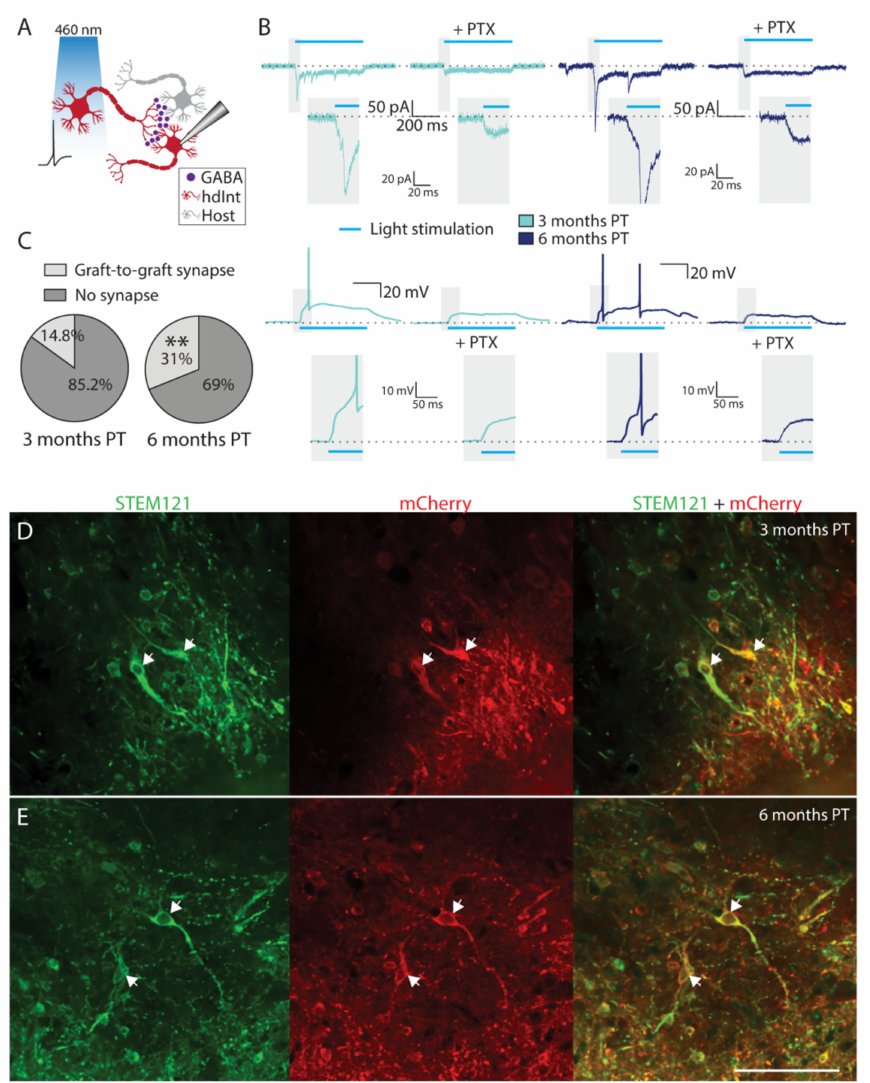
Figure 4. Graft-to-graft synaptic connectivity. ( A ) Cartoon representing a recording from a grafted hdInt receiving inhibitory synapses from another grafted hdInt (a graft-to-graft synapse) activated by blue light. ( B ) Representative traces from recorded hdInts in voltage- and current-clamp mode while illuminating slices by a 500 ms blue light pulse. Note a delayed synaptic response, which is then blocked by PTX, confirming the GABAergic nature of the synaptic connections. These PSCs were observed both at three- and six-months PT. ( C ) The proportion of cells with an observed graft-to-graft synapse was significantly higher at six months, compared to three months PT. ( D , E ) Immunofluores- cent staining of slices used for electrophysiology experiments confirming the expression of mCherry in grafted hdInts. The cells exhibit staining for the human cell marker STEM121 (green) and mCherry (red). **, p < 0.01. The binomial test was used for the comparison of proportions in ( C ). Scale bar 100 µ m. PTX,